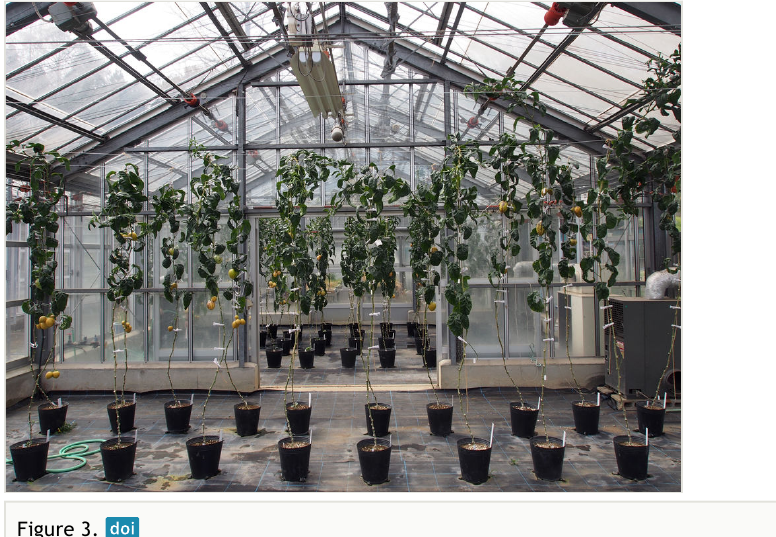
A greenhouse, one of the survey plots in the Atsugi Campus of Tokyo University of Agriculture (TUA), indicated as Plot B in Fig. 1